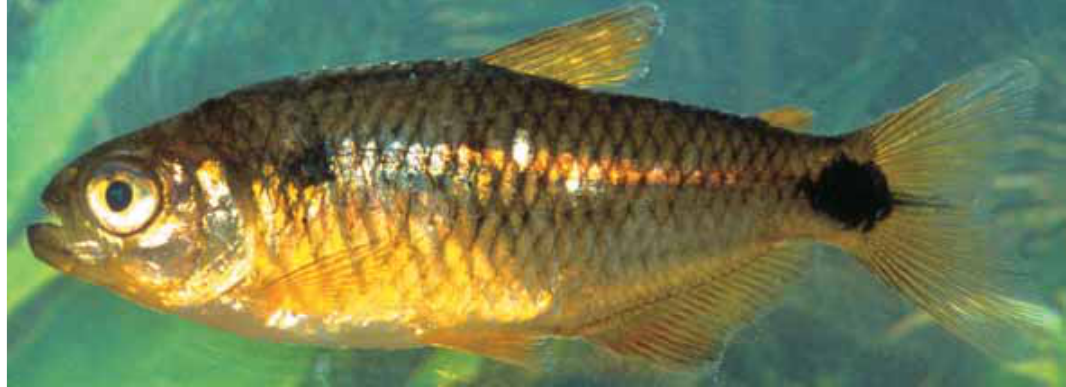
Fig. 3. Hyphessobrycon langeanii , paratype, MZUSP 73272, 37.7 mm SL, Brazil, Mato Grosso, município de Alto Araguaia, córrego Boiadeiro. Photographed in